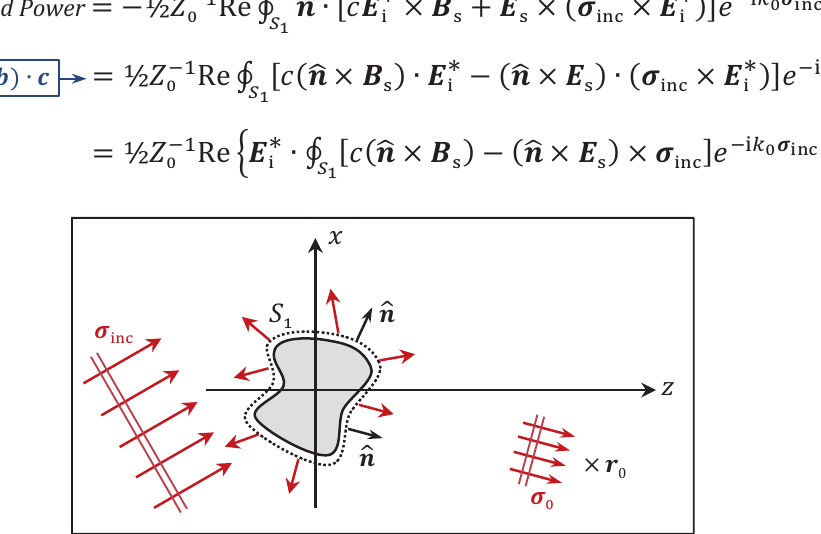
Fig.8 . A monochromatic plane-wave propagating along the unit-vector (cid:2252) small object in the vicinity of the origin of the coordinate system. The scattered electric and magnetic fields on the closed surface (cid:1845) The surface normals (cid:2196)(cid:3549) at every point on (cid:1845)